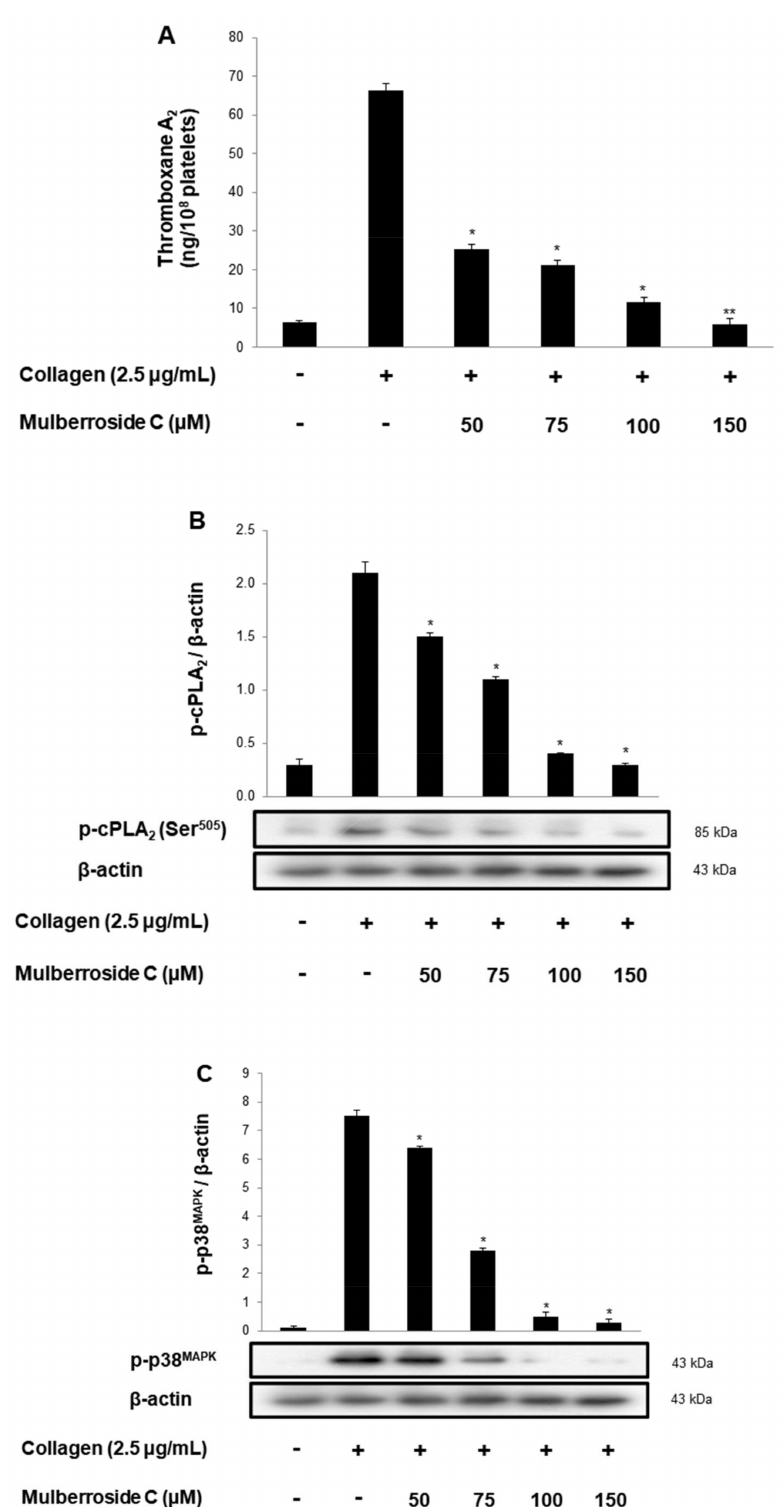
Figure 5. Effects of mulberroside C on TXA 2 production, cPLA 2 , p38 phosphorylation ( A ) Ef- fects of mulberroside C on collagen-induced TXA 2 generation; ( B ) Effect of mulberroside C on collagen-induced cPLA 2 phosphorylation; ( C ) Effect of mulberroside C on collagen-induced p38 phosphorylation. Measurement of TXA 2 generation and Western blot was performed as described in Section 2. The data are expressed as the mean ± standard deviation ( n = 4). * p < 0.05, ** p < 0.01 versus the collagen-stimulated human